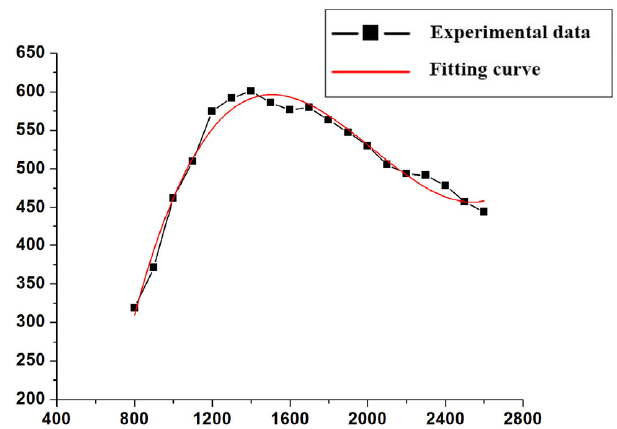
Figure 3. External characteristics of the engine and fitting curve.